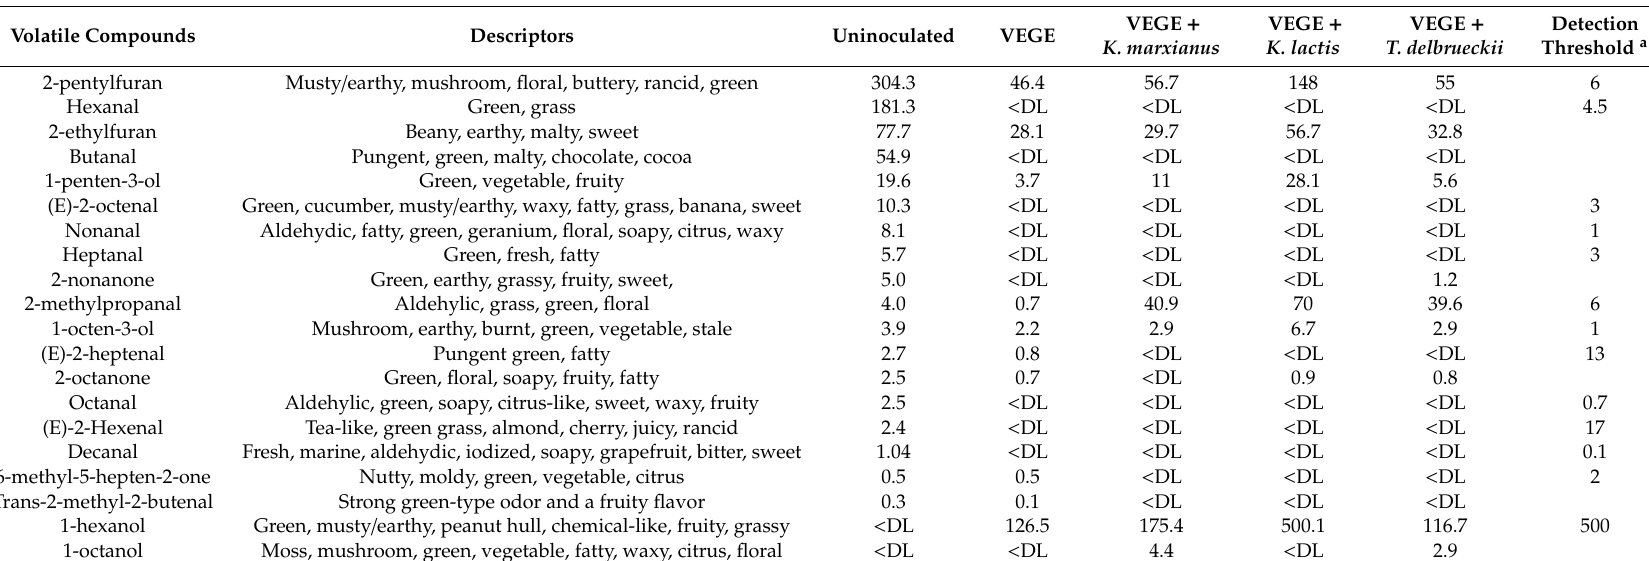
Table 3. Concentrations of the o ff -flavor molecules in the non-fermented and fermented samples ( µ g /